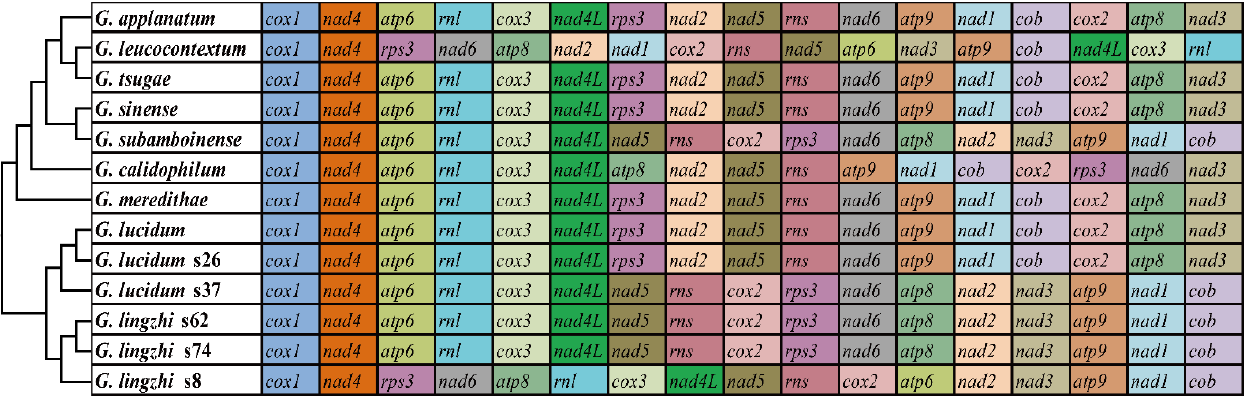
Figure 6. Gene order comparation between 13 Ganoderma species. All genes are shown in order of occurrence in the mitochondrial genome, starting from cox1 . Fifteen core protein-coding genes and two rRNA genes were included in the gene arrangement analysis. The phylogenetic positions of 13 Ganoderma species were established using the Bayesian inference (BI) method and maximum likelihood (ML) method based on concatenated mitochondrial genes. Species and NCBI accession number used for gene arrangement analysis in the present study are listed in Supplementary Table S7.